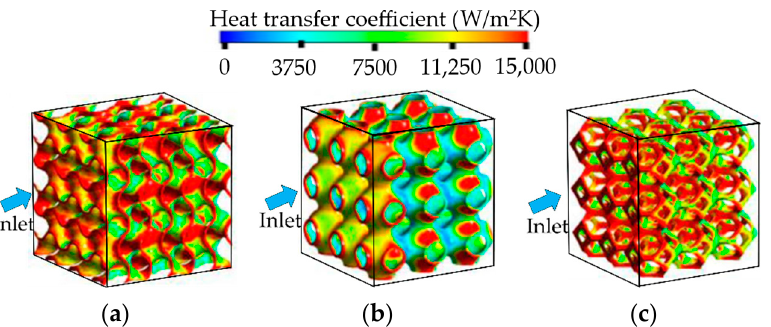
Figure 23 . Local heat transfer distribution at the velocity inlet of 7 cm/s: ( a ) Sheet-Gyroid; ( b ) sheet-Primitive; ( c ) TKD structures [47].